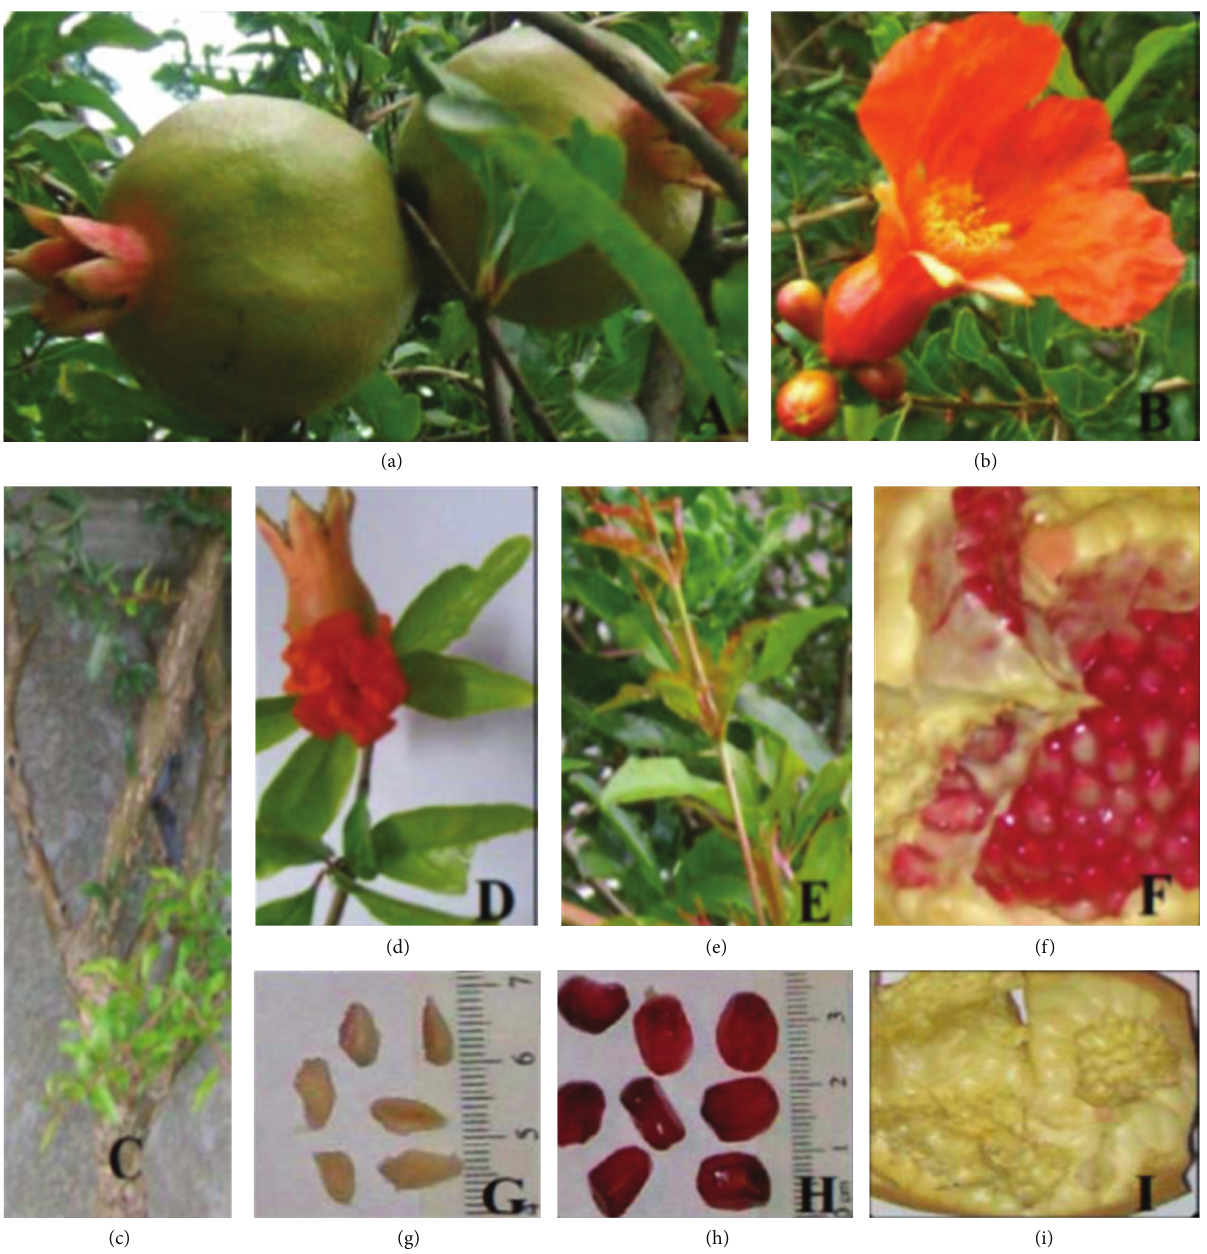
Figure 1: Different anatomical parts of P. granatum tree and fruit. (a) Unripe fruit; (b) flower; (c) stem; (d) flower and tubular calyx; (e) young leaves at the branch endings; (f) the fruit’s rind with membranous extensions forming compartments which contain the juicy arils; (g) seeds; (h) arils (juicy pulp coating the seed); (i) pomegranate inner